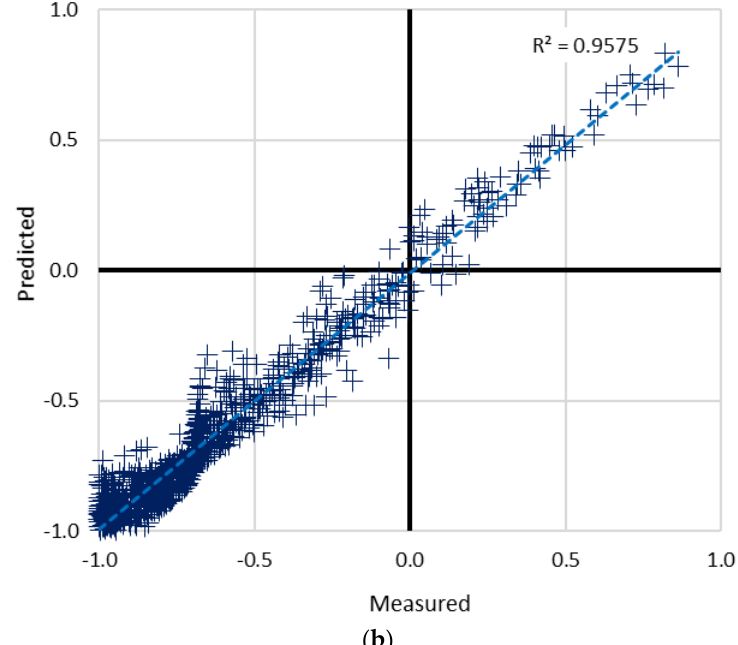
Figure 14. Training and testing outcomes form PSO – ANN model in estimating F ult.; ( a ) PSO-ANN-training dataset, ( b ) PSO-ANN-testing dataset